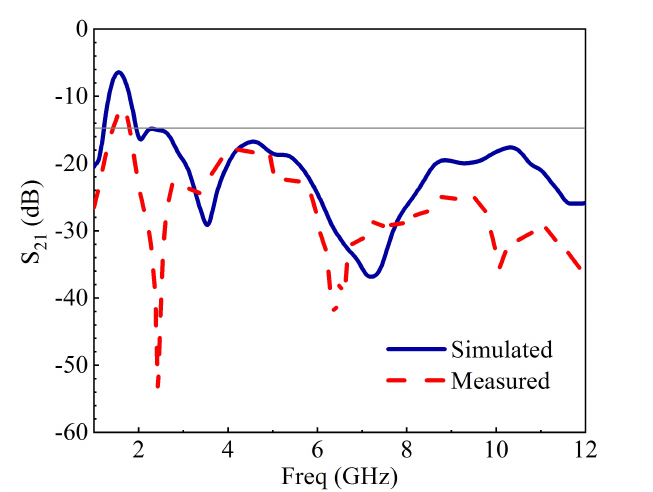
Figure 22. Measured and simulated S 21 of the designed antenna.